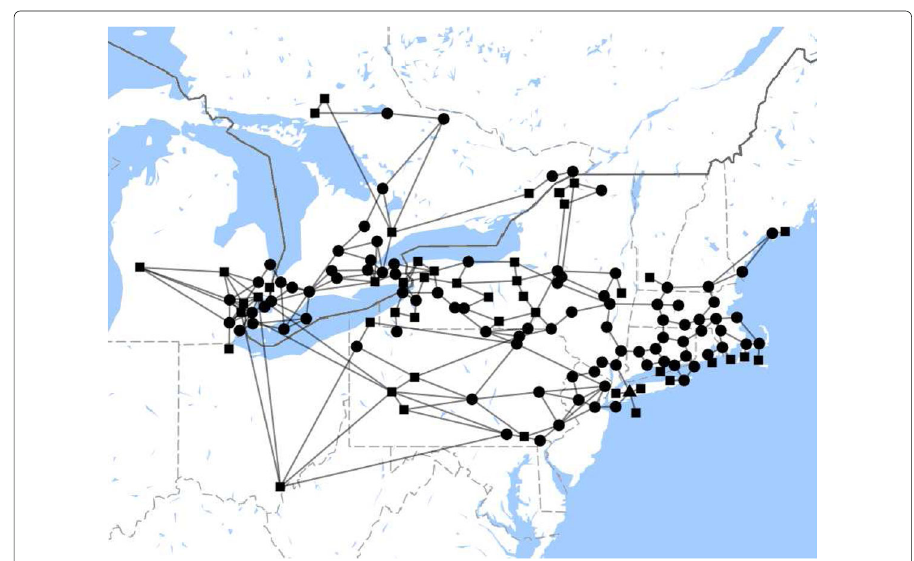
Fig. 2 NPCC System Map. The NPCC 140-Bus system is a reduced model for the power grid of the northeastern United States and Canada, plotted here overlaid on a map of the region. In this figure only, bus types are distinguished by the nodes’ symbols (circles are load buses, squares are generator buses, and triangles are swing